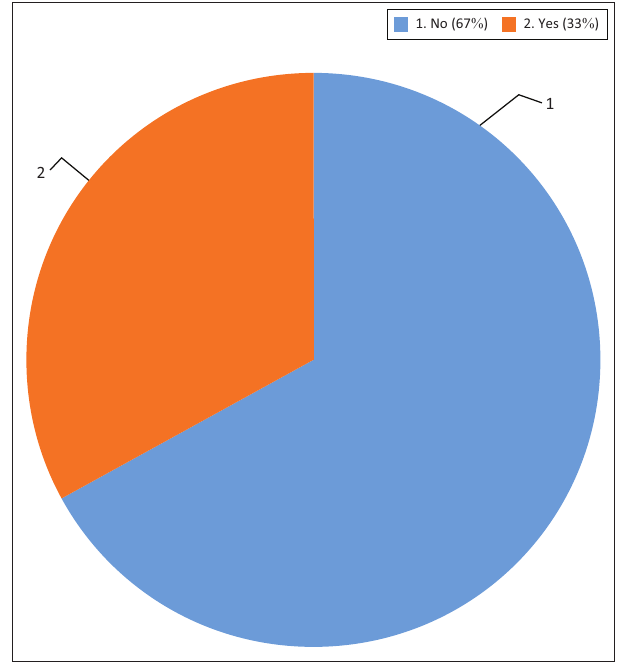
FIGURE 6 : Community knowledge on public participation.